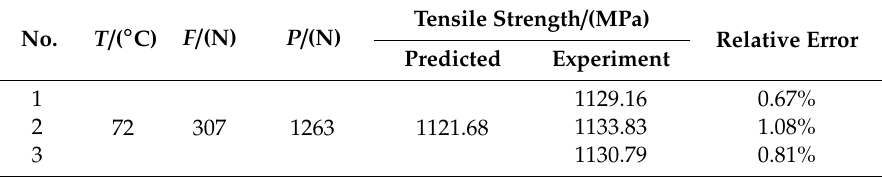
Figure 7. Ramp function graph of desirability and the optimized result for tensile strength. Table 4. Results of validation experiments using the optimal parameter combination.